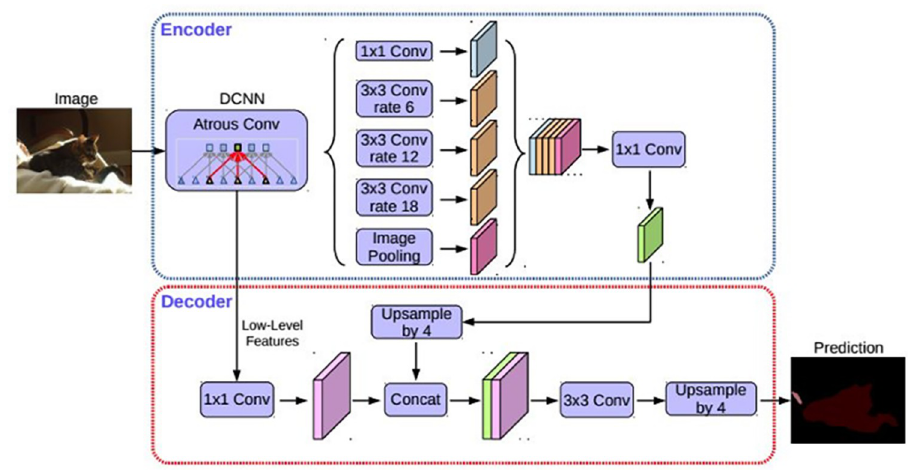
Fig 2. The overall architecture of the DeepLabv3+ model